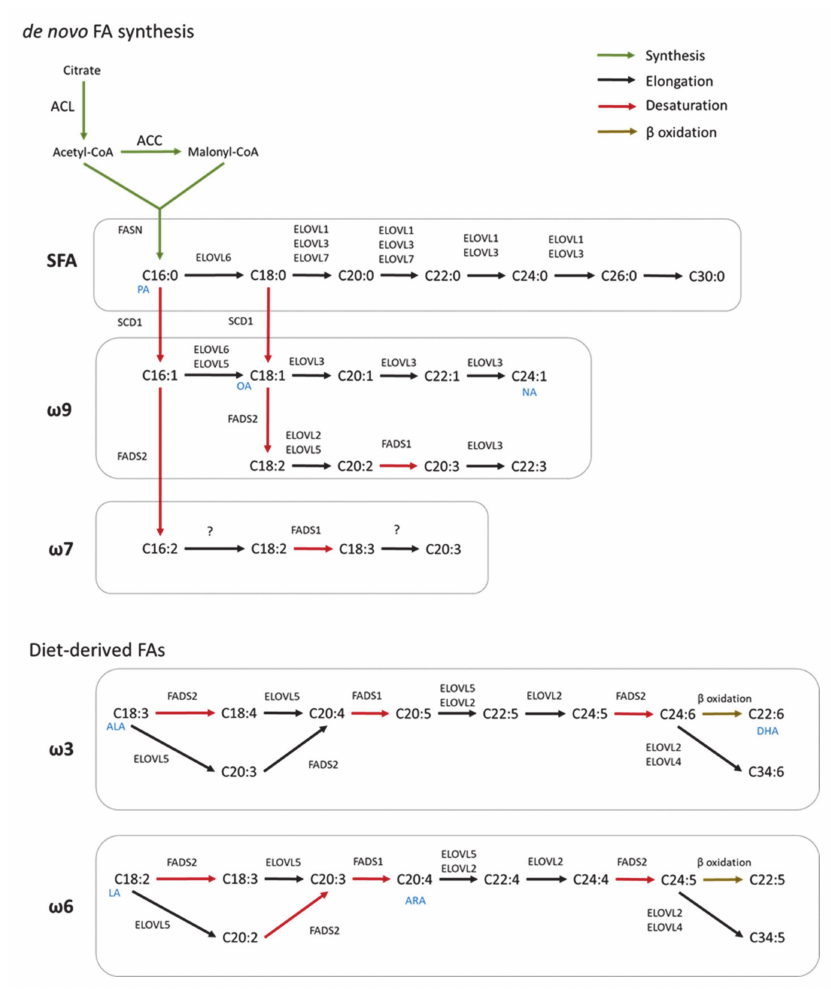
Figure 1. Scheme of FA synthesis in mammals. FAs are elongated (ELOVL1–7) and/or desaturated (SCD, FADS) to generate complex FAs. Long chain saturated FAs (LCSFA) and unsaturated FAs of ω 9 and ω 7 can be synthesized from palmitic acid (PA, C16:0) produced by the de novo FA synthesis. Long-chain unsaturated FAs of the ω 6 and ω 3 series can only be synthesized from essential diet- derived FAs (OA, oleic acid; NA, nervonic acid; ALA, α -linolenic acid; DHA, docosahexaenoic acids; LA, linoleic acid; ARA, arachidonic